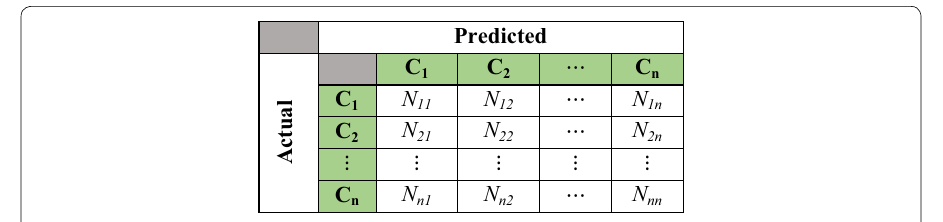
Fig. 1 Confusion matrix for multi-class